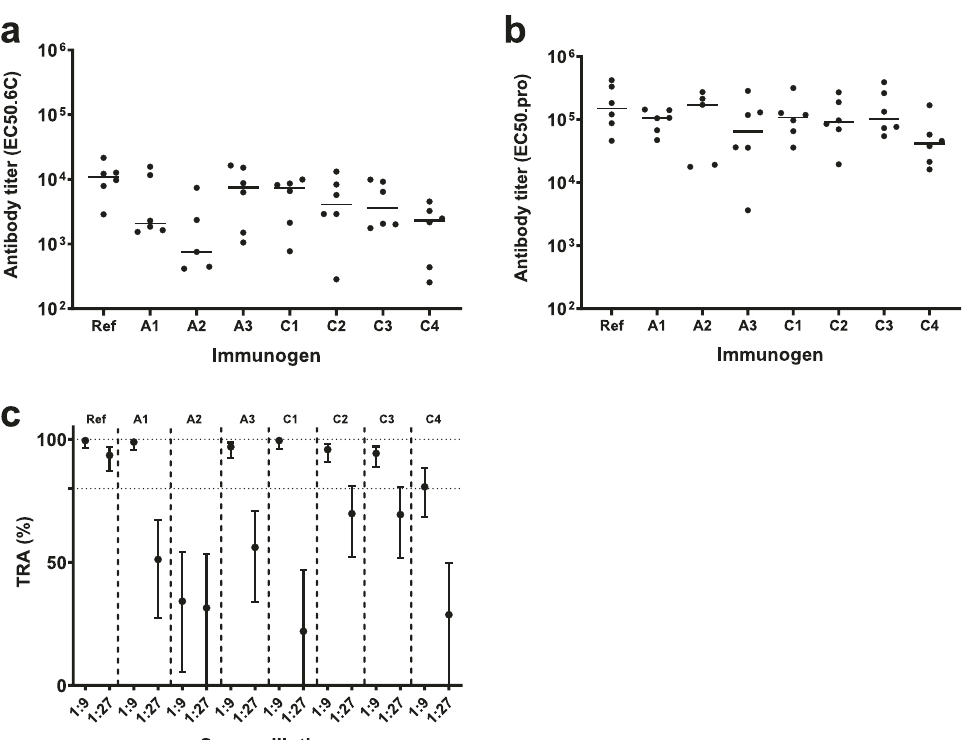
Fig. 2 Immunogenicity and functional activity of Pro-6C chimeras. Groups of mice ( n = 6) were immunized with 10 µg of Pro-6C constructs with alum. Day-56 serum was tested for antibody reactivity on ELISA plates coated with Pfs48/45-6C ( a ) and Pfs230-Pro ( b ). Antibody titers (dots represent individual mice) are expressed as EC50 values. Horizontal lines represent median values. c Functional activity of pooled sera (1:9 and 1:27 dilution) in the standard membrane-feeding assay (SMFA). Reported values and 95% con fi dence intervals (bars) are determined by general linearized mixed models and used oocyst-count data from two independent SMFA experiments with 20 mosquitoes per condition and experiment. Transmission-reducing activity is calculated by comparing with a nonserum control included in each